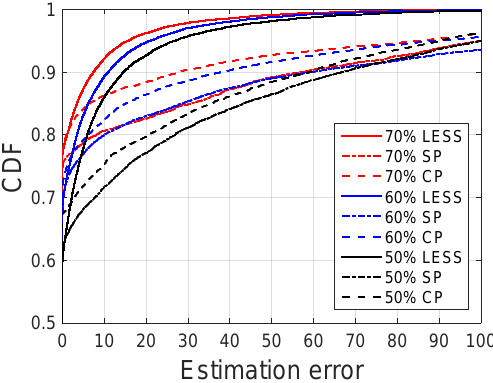
Figure 11. Comparison between LESS-RS and Spline-based approach (SR = 0.5, 0.6, 0.7).